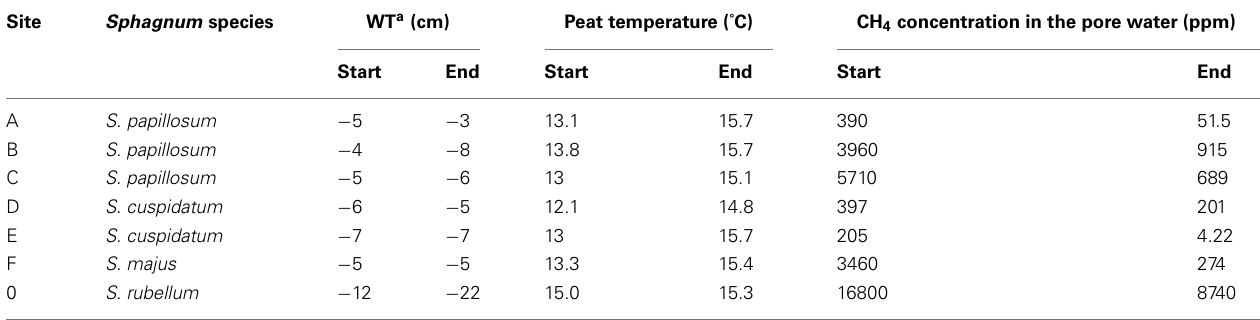
a WT = water table level as measured from the peat